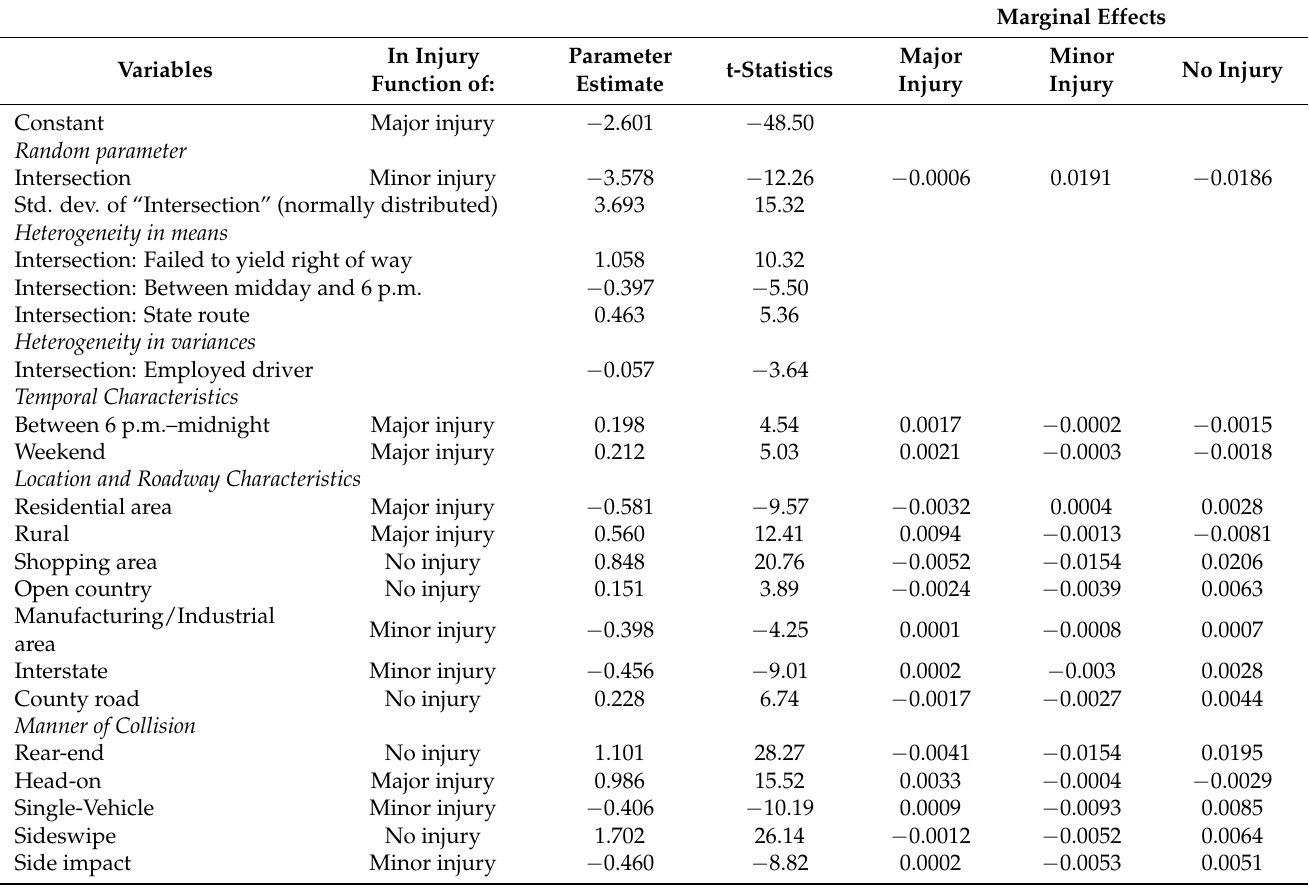
Table 5. Severity model results and averaged marginal effects after shelter-in-place period.